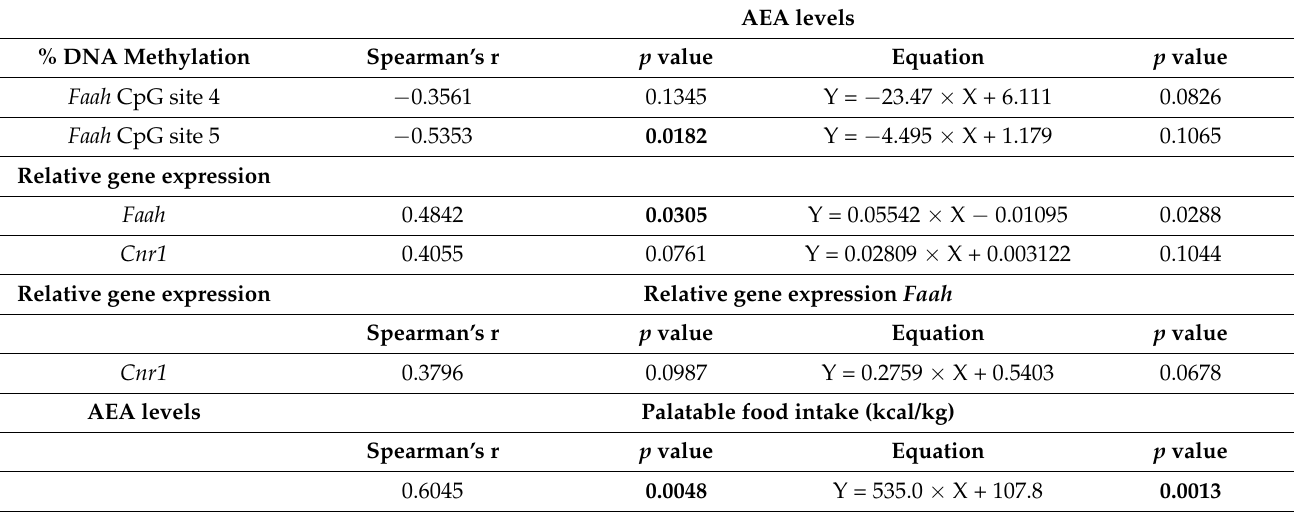
Table 3. Correlation analysis between the levels of AEA and the percentage of DNA methylation and gene expression in Faah and Cnr1 . Correlation analysis between gene expression of Faah and Cnr1 . Correlation analysis between the levels of AEA and the palatable food intake (kcal/kg, calculated as a mean of 120-min time point palatable food intake of the four feeding tests) in each experimental group. Data were compared by Spearman’s rank correlation coefficient; p and r values are